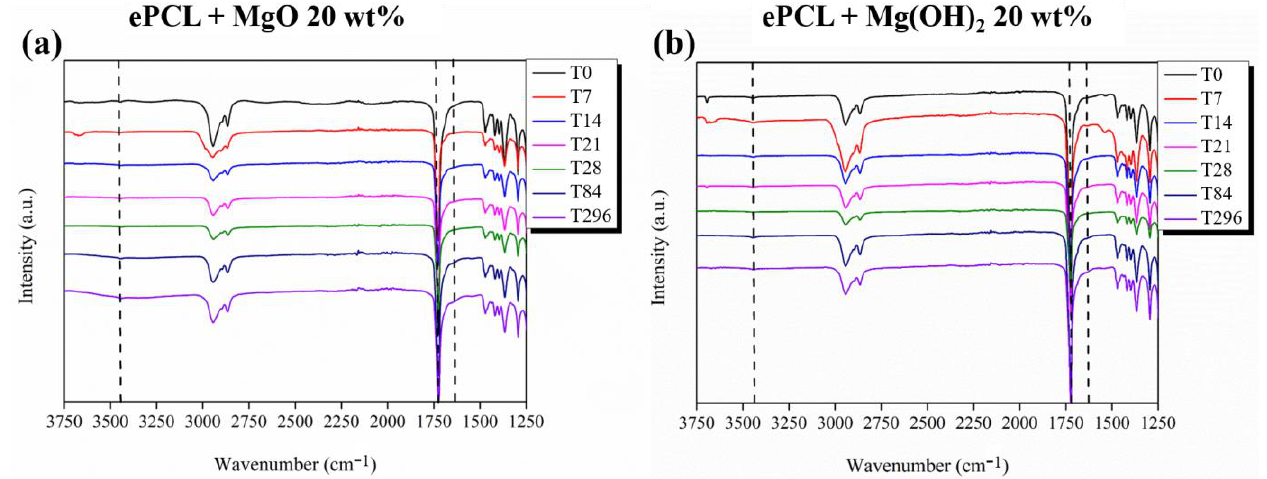
Figure 7. FTIR spectra of ( a ) ePCL + MgO 20 wt% and ( b ) ePCL + Mg(OH) 2 20 wt% at different extraction times.